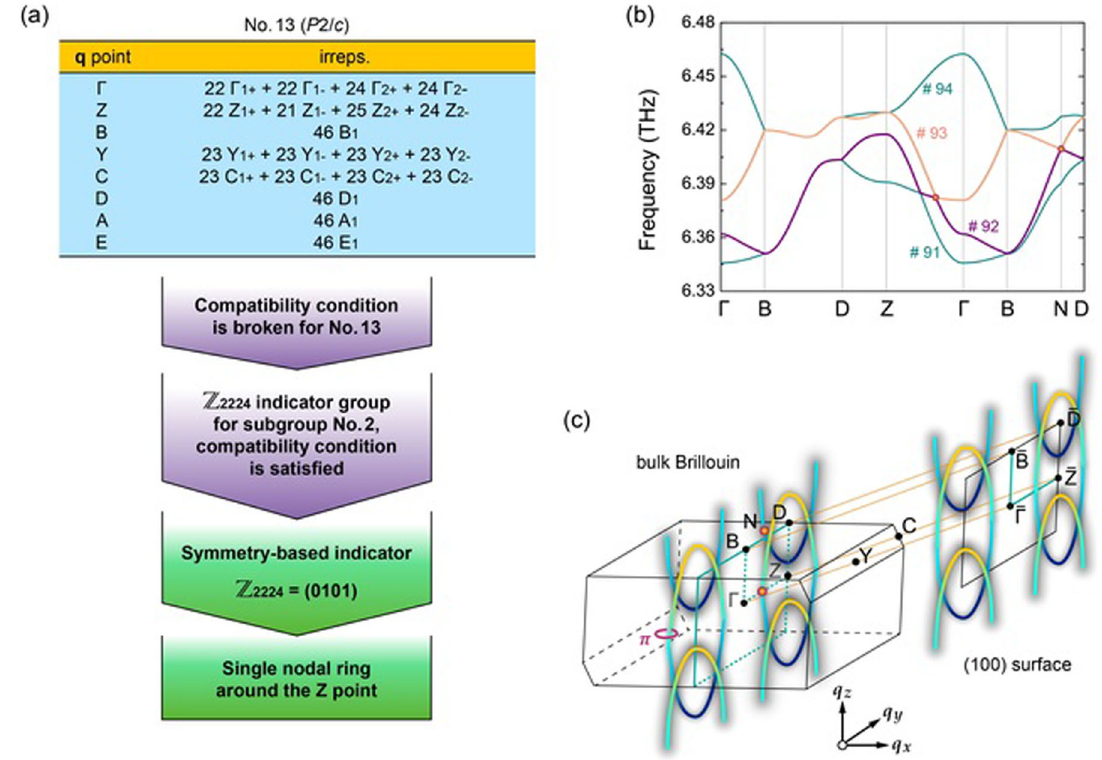
Fig. 3 Topological properties of SnIP. a Diagnosis process for the single nodal ring around the Z point using symmetry-based indicator theory for the lowest 92 bands. b Phonon band crossings between branches 92 and 93 and c the nodal rings in the bulk Brillouin zone, as well as their projections on the (100)